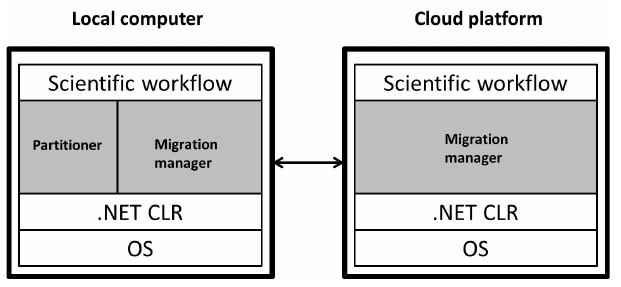
Figure 2: Components of Emerald